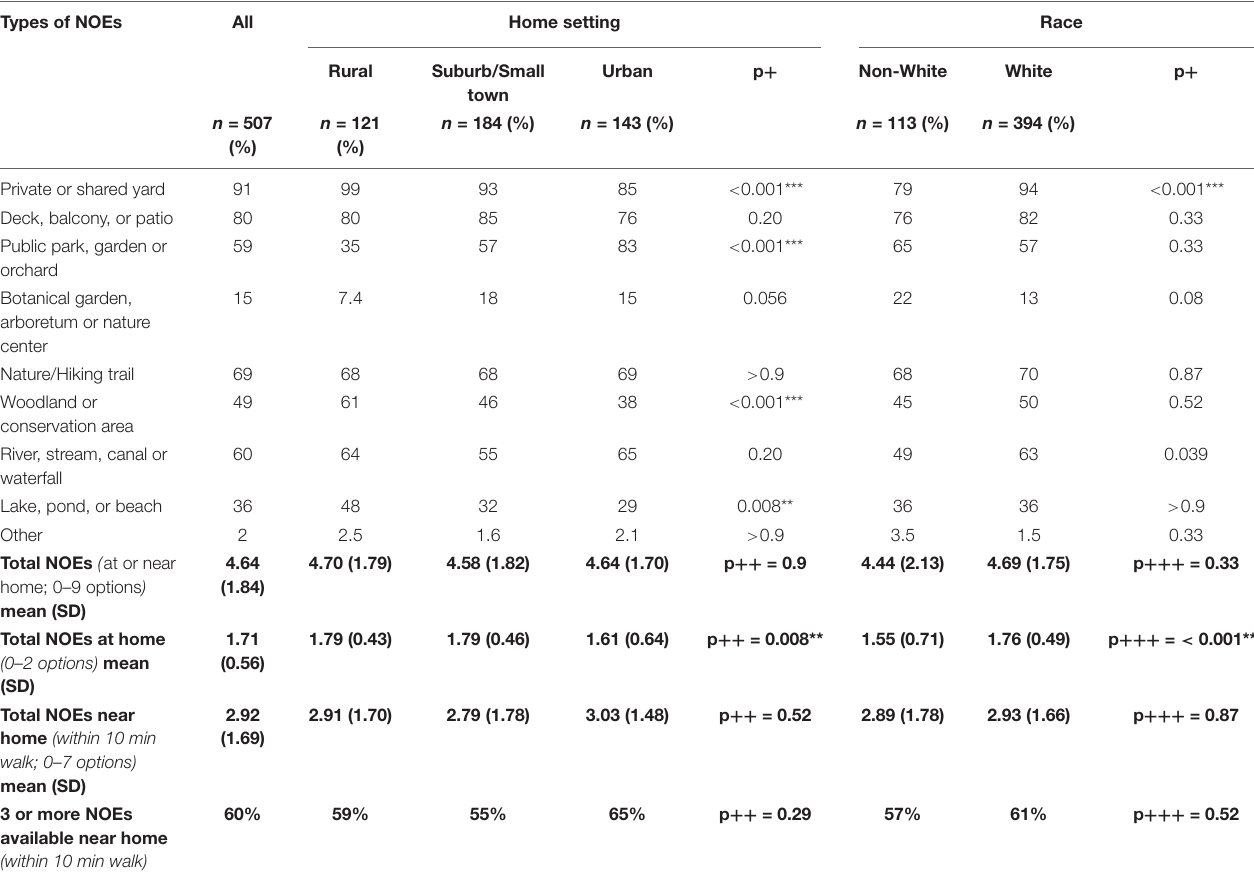
TABLE 8 | Differences in accessibility of NOEs at and near home by all participants and home setting and racial subgroups. Types of NOEs All Home setting Race Rural Suburb/Small Urban p + town